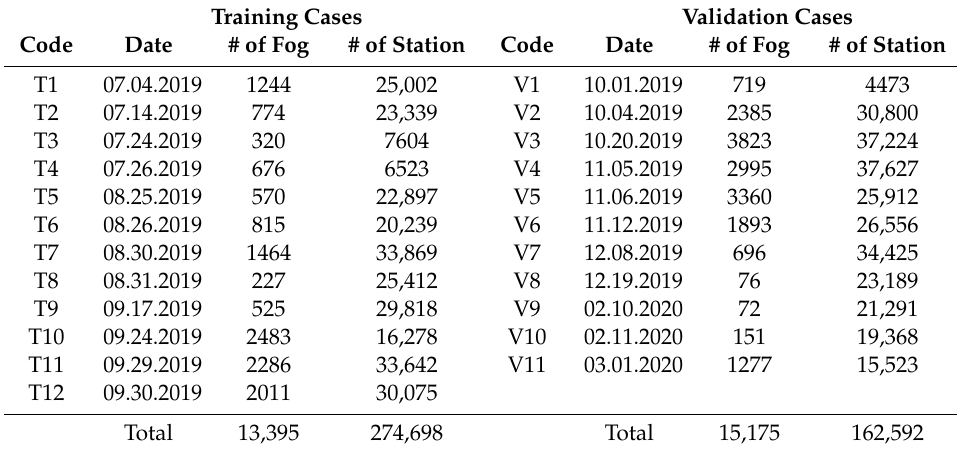
Table 2. Summary of the fog cases used for training (T) and validation (V) of the fog detection algorithm. The number of fogs and stations indicate the number of visibility meters, showing a visibility of less than 1 km and the total number of visibility meters used for validation,